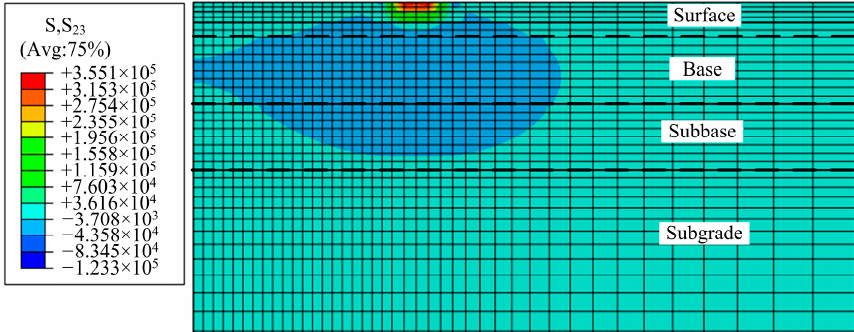
Figure 14. Shear stress in middle section when load moves over it at initial speed of 10 km/h.